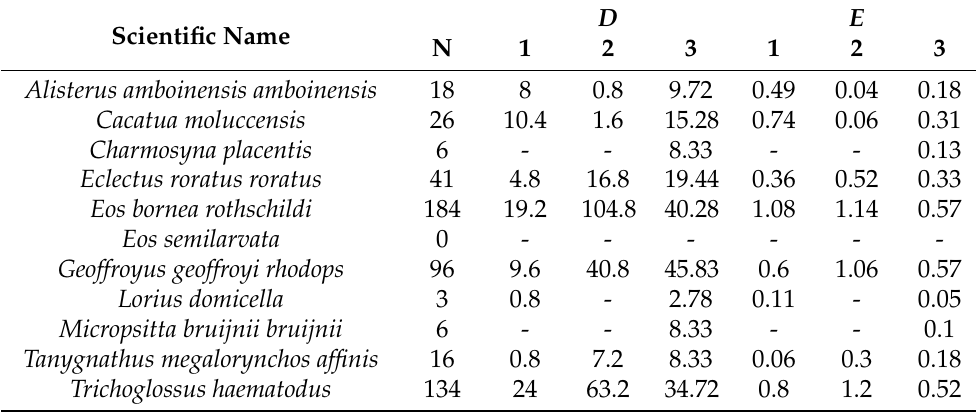
Table 2. Parrot densities ( D = individuals/km 2 ) and species evenness ( E ) at different transects conducted in the Manusela National Park, Seram, Indonesia, including Masihulan Camp (1), Sasarata Camp (2), and Manusela NP buffer zones (3). For exact locations, see Figure